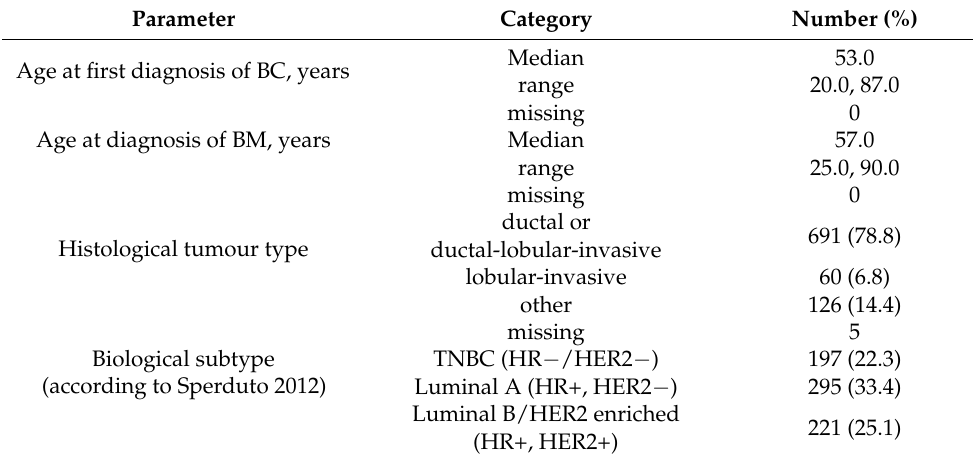
Table 2. Patients’ characteristics ( n =